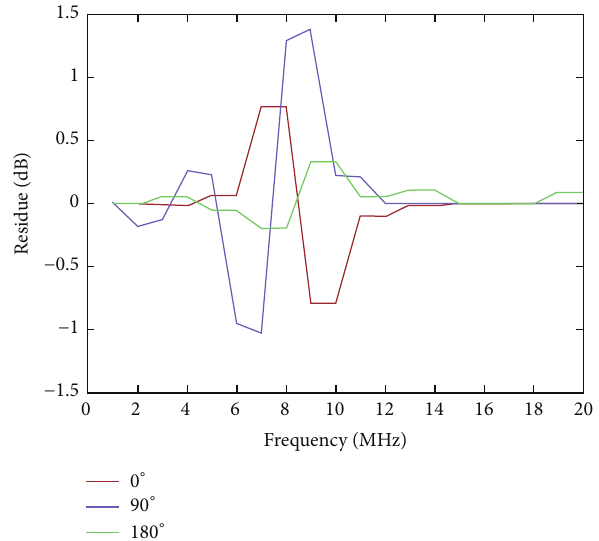
Figure 6: The ship target residue varies with frequency and angle where the 𝑥 -axis is frequency and 𝑦 -axis is residue. The red line represents the residue changing trend with frequency when angle is 0 ∘ , blue line represents 90 ∘ , and green line is 180 ∘ .